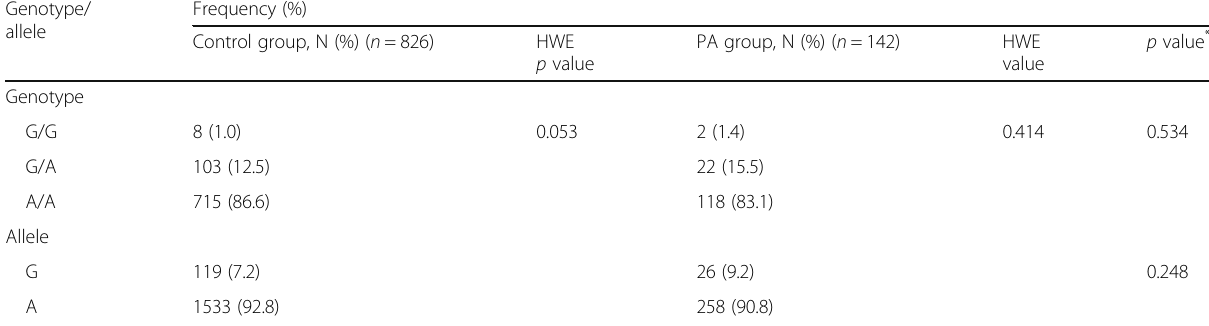
Table 2 The frequency of genotypes and alleles of rs3740051 in patients with PA and control subjects Genotype/ allele Control group, N (%) ( n = 826)